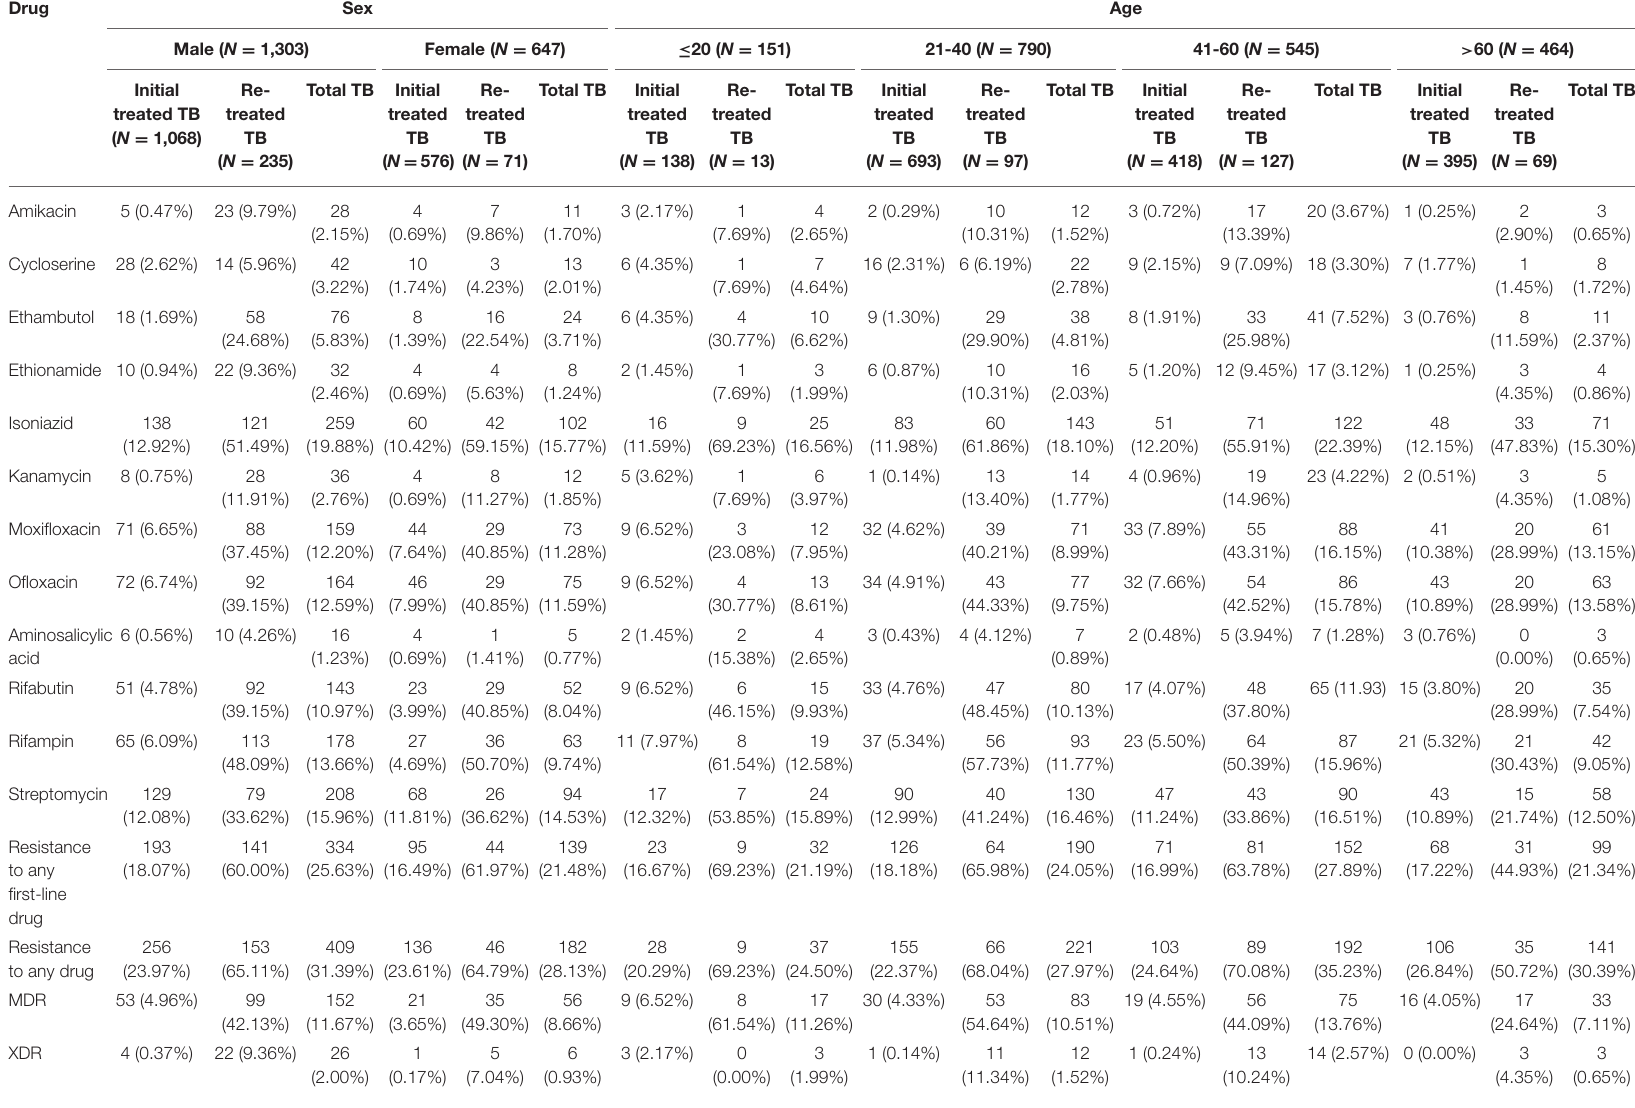
TABLE 3 | The drug resistance profile in different genders and age